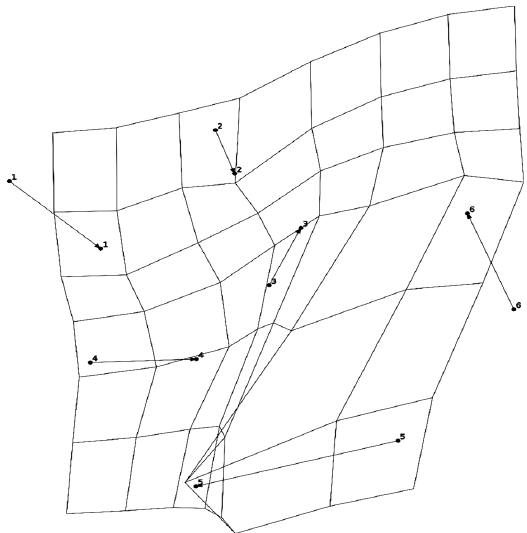
Figure 13. Example of a distorted representation between the initial and the rebuilt configuration for Participant 11 (B5 in Table 2) after using the edge projection (EDP) technique.